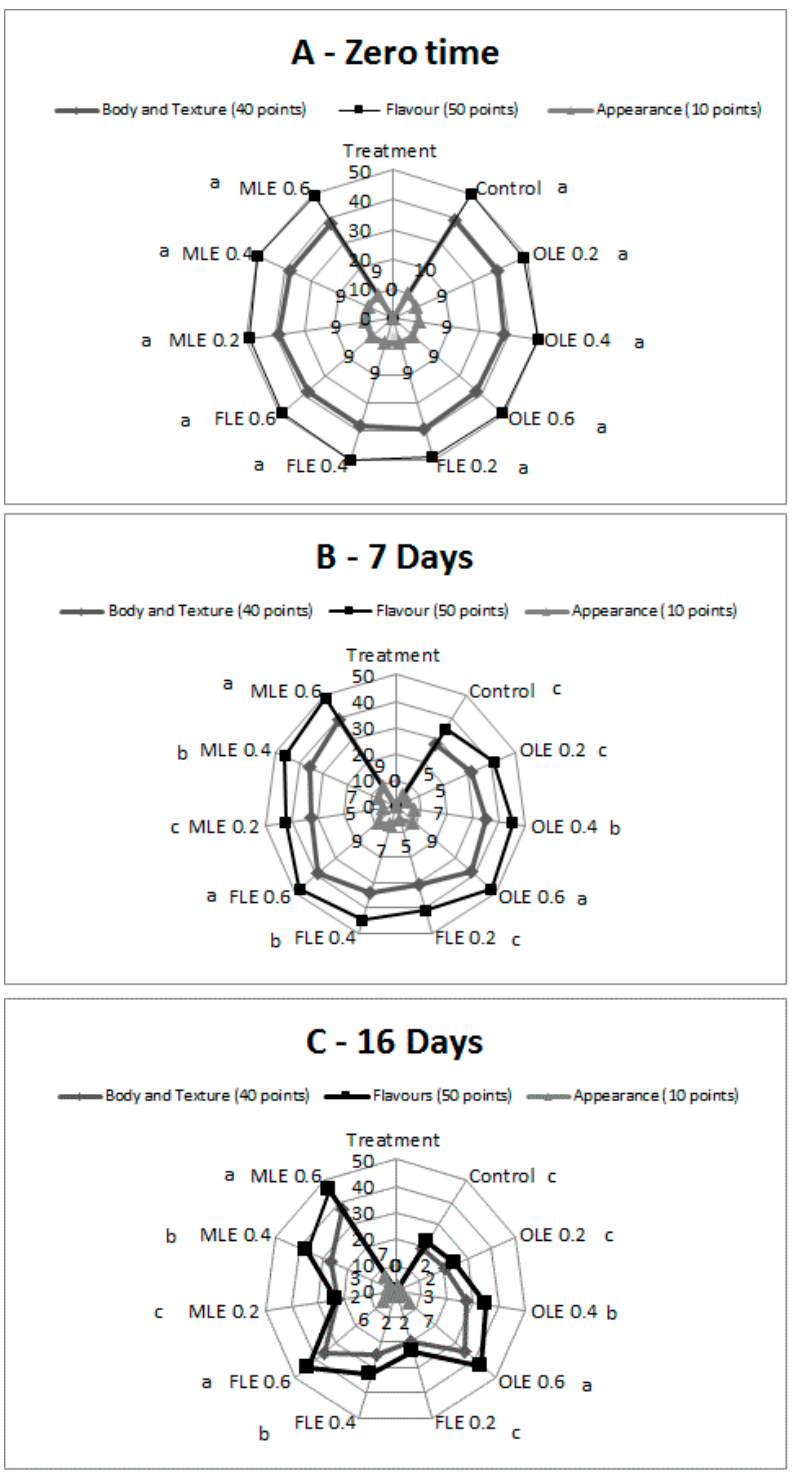
Figure 7. Sensory profile analysis of pasteurized bu ff alo milk samples enriched with di ff erent concentrations of FLE, OLE, and MLE, during 16 days of storage, at 5 ◦ C. ( A ) zero time, ( B ) after 7 days at 5 ◦ C and ( C ) after 16 days at 5 ◦ C Significant di ff erences between di ff erent treatments are labeled significant di ff erences between di ff erent treatments by using di ff erent